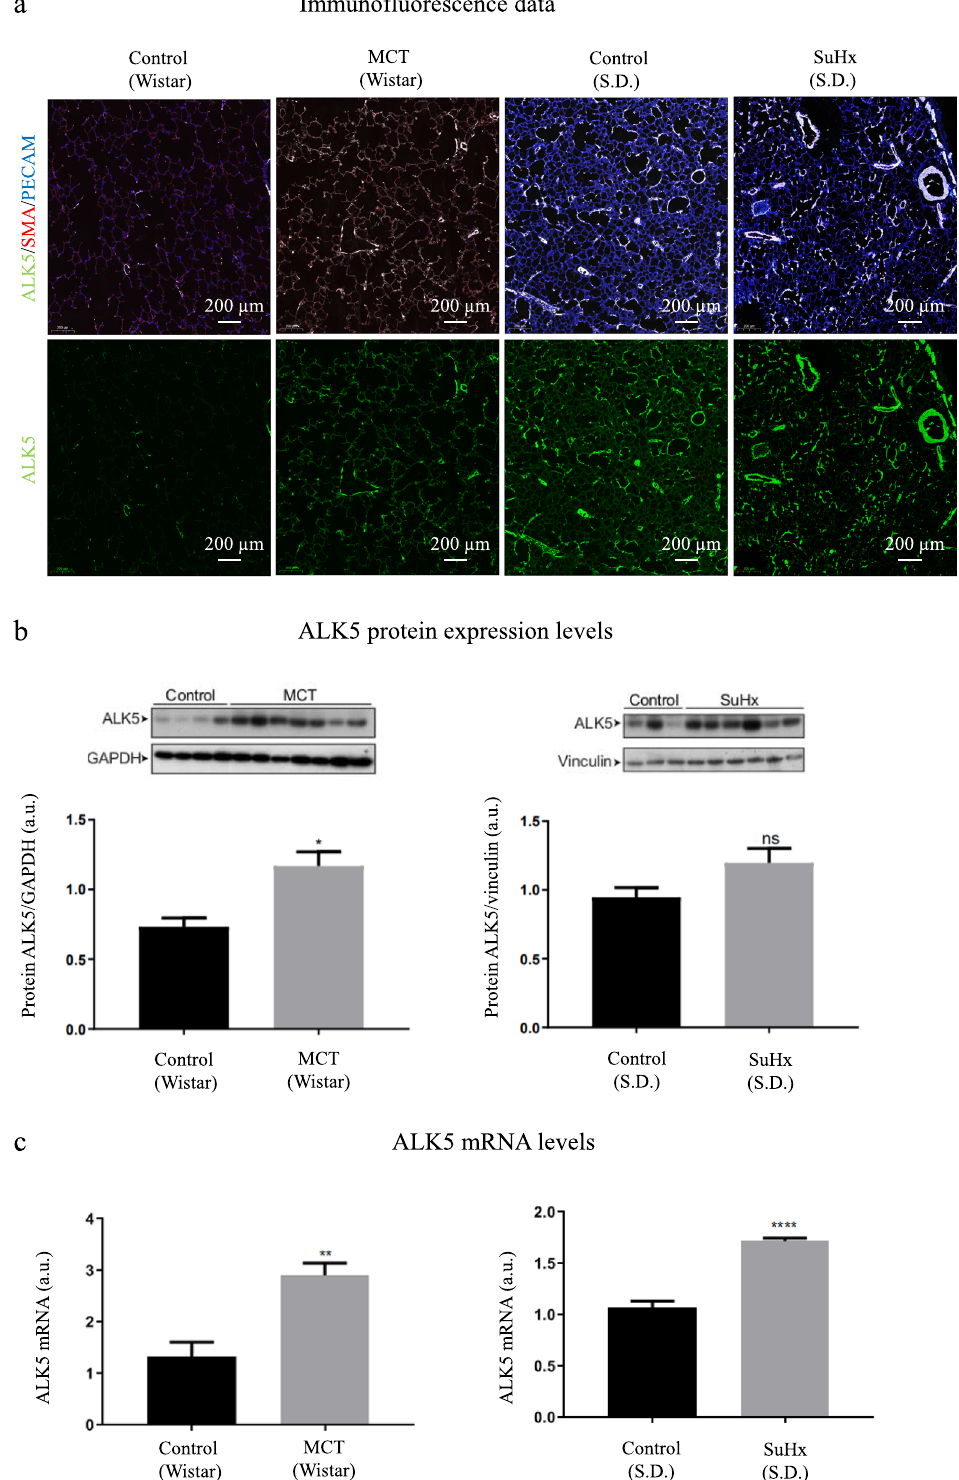
Fig. 3 ALK5 expression in control, MCT-exposed (Wistar) and SuHx-exposed (S.D.) rat lungs: a immunofluorescence; b protein expression levels of ALK5 based on Western blot analysis. The western blot gel is cropped to improve the clarity of the image. See the Additional file 1 (Fig. 1) for the uncropped image; c mRNA levels of ALK5. ** represents a significant difference with p < 0.01, **** a significant difference with p <